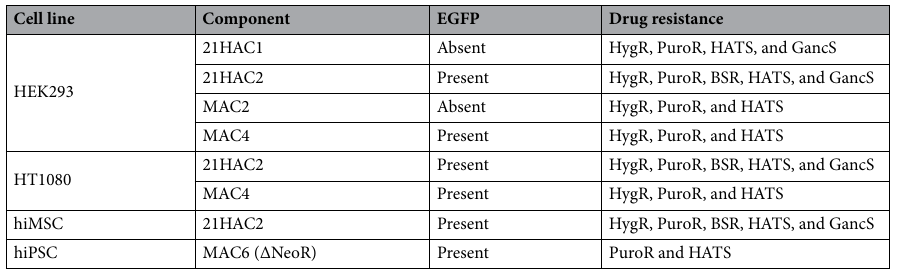
Table 1. List of human cell lines that contained HACs/MACs. Cell lines, HACs/MACs, EGFP marker, and drug resistance are summarised. Regarding drug resistance, R indicates cells resistant to antibiotics, i.e., Hyg hygromycin, Puro puromycin, BS blasticidin S, and S indicates that cells are selectable by drugs, i.e., HAT hypoxanthine-aminopterin-thymidine medium and Ganc